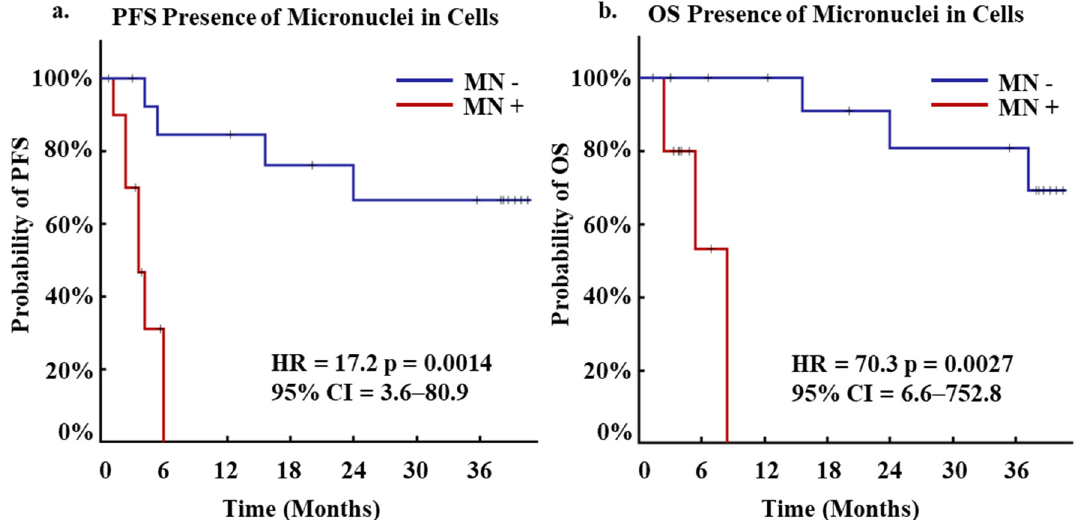
Figure 3. Kaplan-Meier of PFS and OS for Micronuclei positivity in patients at first blood draw. ( a ) Kaplan-Meier of PFS for patients who presented positivity for micronuclei (red, N = 11) or negative (blue, N = 14). ( b ) Kaplan-Meier of OS for patients who presented positivity for micronuclei (red, N = 11) or negative (blue, N= 14).